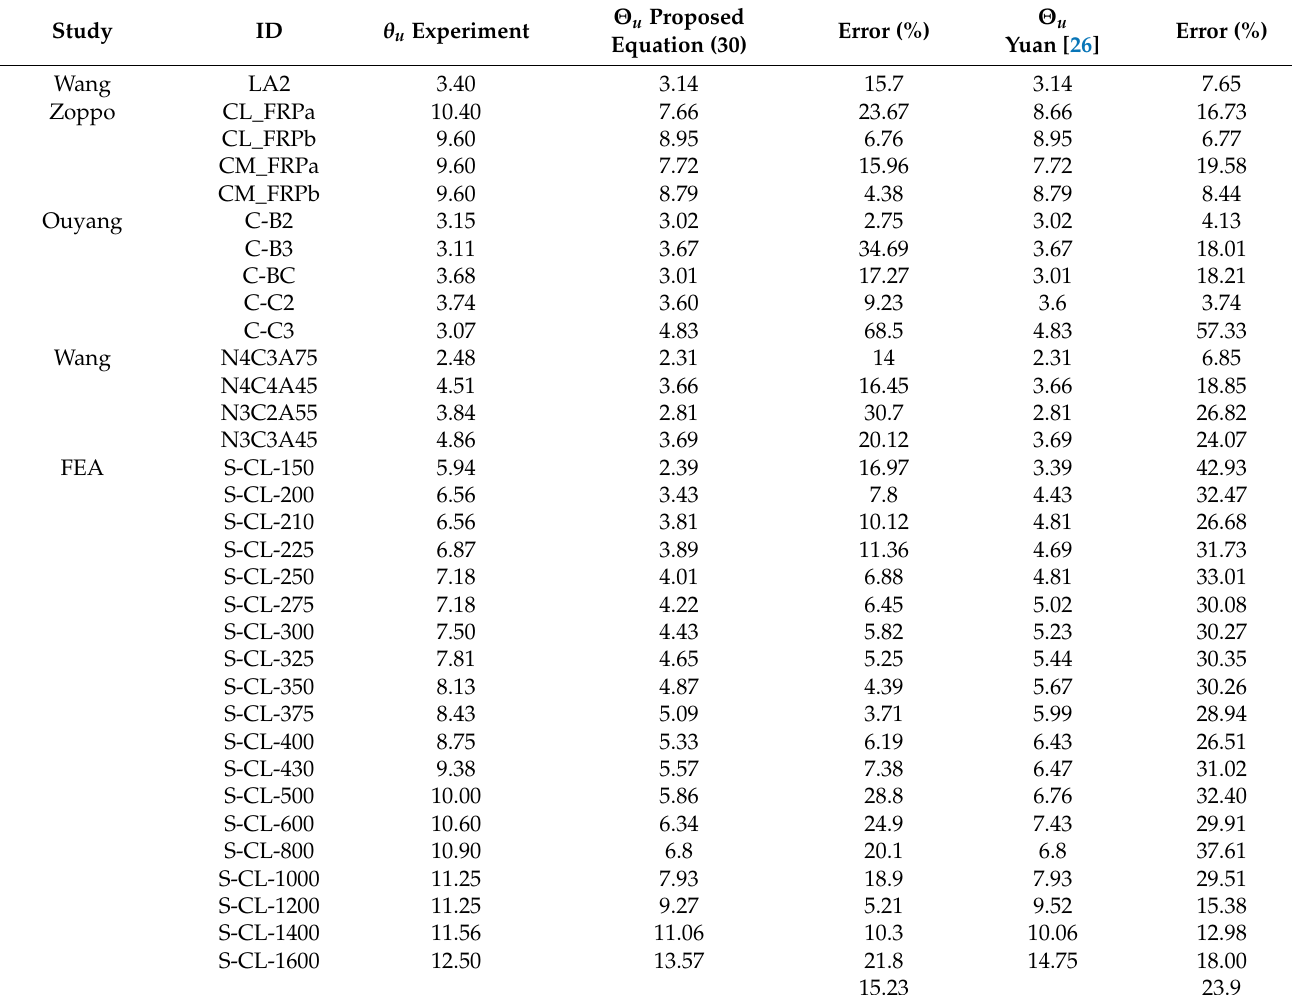
Table 8. Comparison of FEA and experimental dataset [37–40] and the proposed θ u